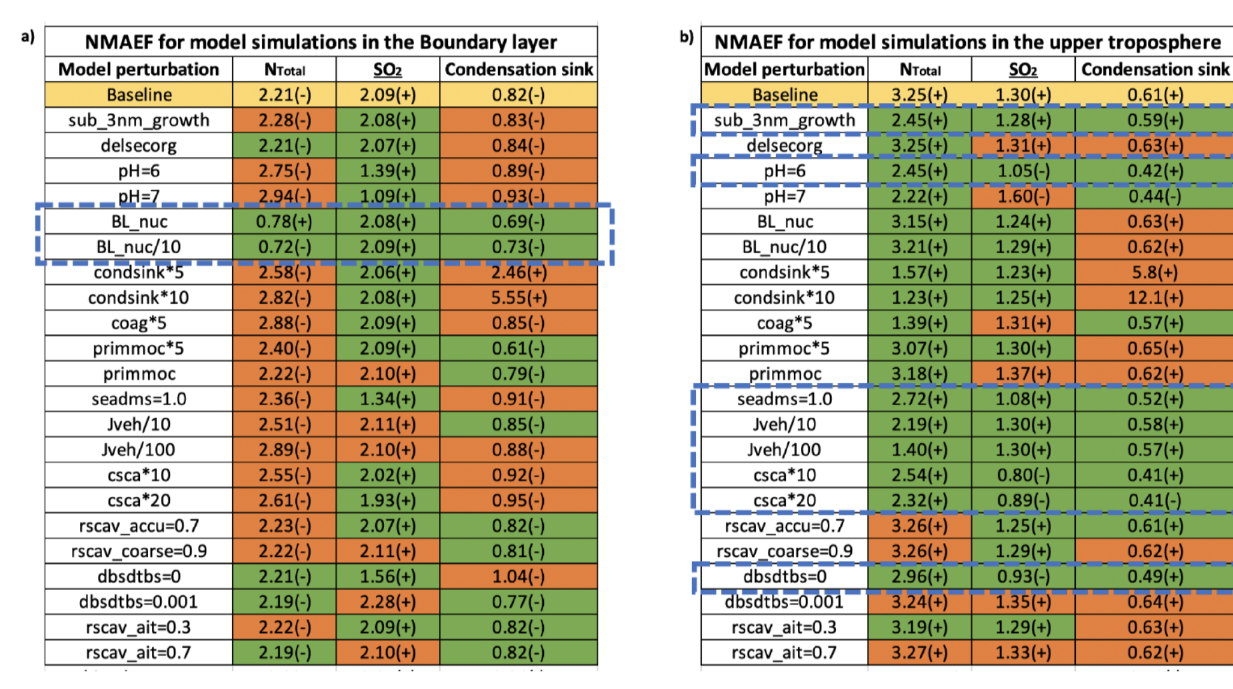
Table 2. Normalised mean absolute error factor (NMAEF) with respect to N Total , SO 2 and condensation sink for different model simulations. NMAEF values for the baseline simulation are highlighted in yellow. NMAEF values that are less than or equal to the baseline simulation are highlighted in green. NMAEF values that are greater than the baseline simulation are highlighted in orange. The plus ( + ) and minus ( − ) signs next to each NMAEF value indicate whether the bias is positive or negative. The dotted blue box indicates the model simulation for which NMAEF values for N Total , SO 2 and condensation sink are less than the baseline simulation simultaneously: (a) boundary layer (below 1km) and (b) upper troposphere ( >